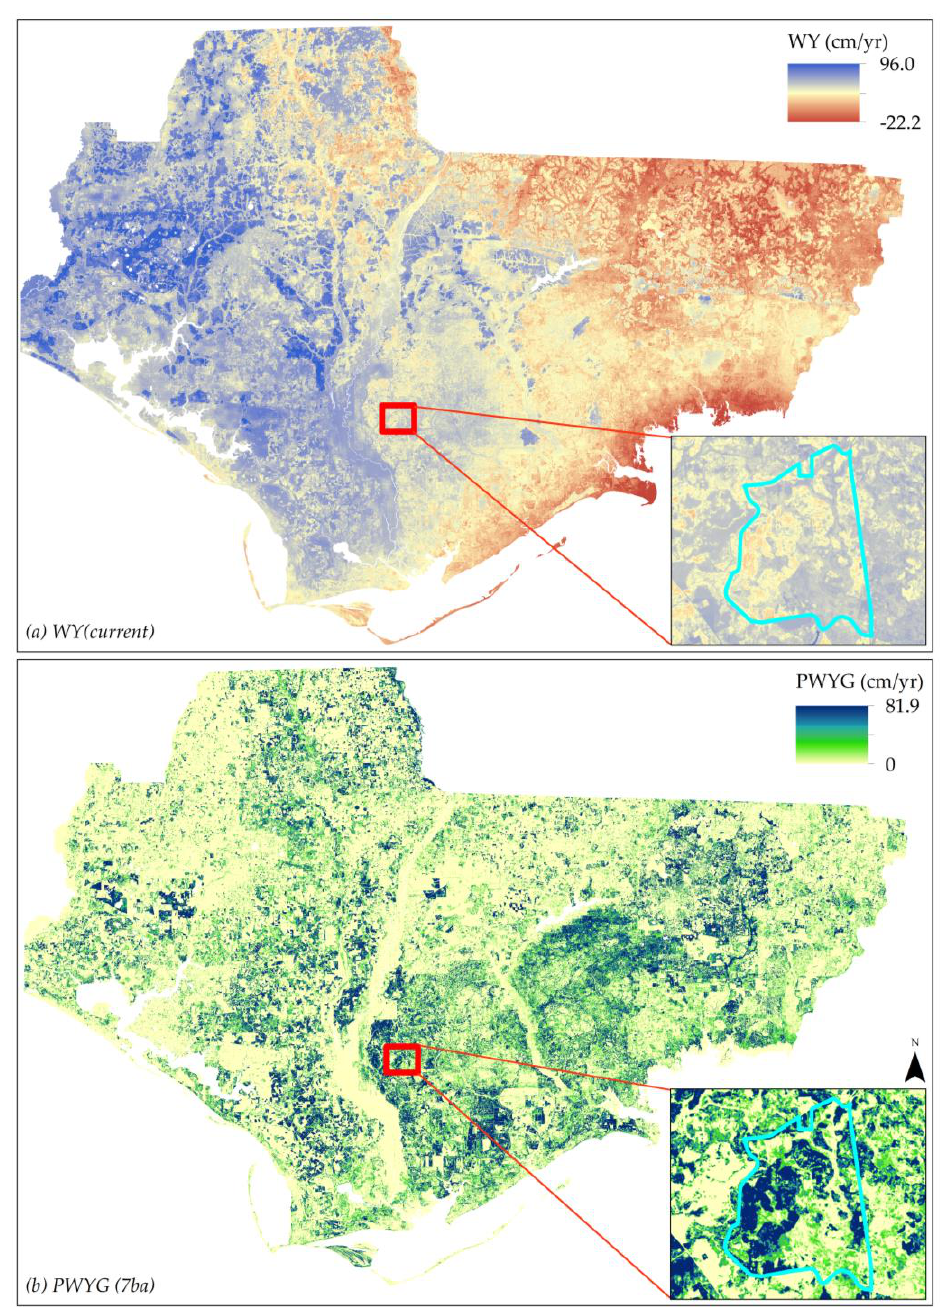
Figure 6. Results of the spatial water yield analysis (cm/yr) with ‘current’ (2018) pine LAI and mean aridity ( a ). Potential water yield gain from pine basal area thinning to 7 m 2 ha −1 shown in ( b ). Inset maps show details of forest timber-management compartment 68.